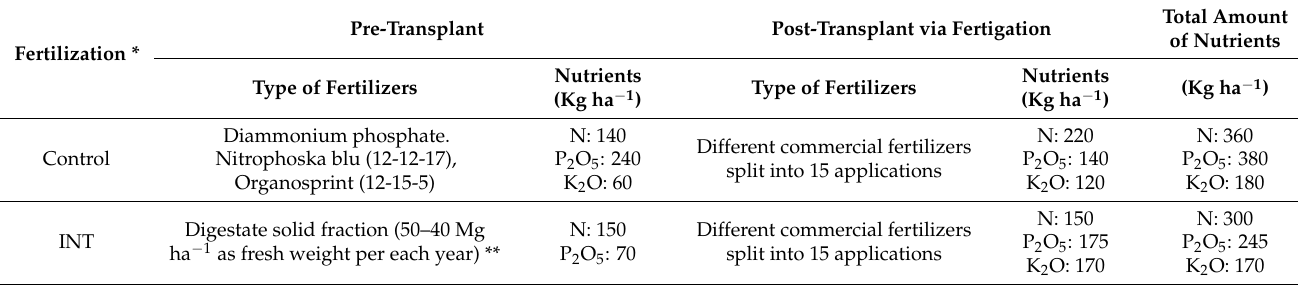
Legend: * Control is the standard fertilization applied by farmers, INT is the integrated fertilization with digestate and reduced rates of N-P fertilizers; ** these amounts contained 150 kg ha − 1 of total N to comply with Action Plan of Campania Region [5] following to the Nitrate Directive (Council Directive